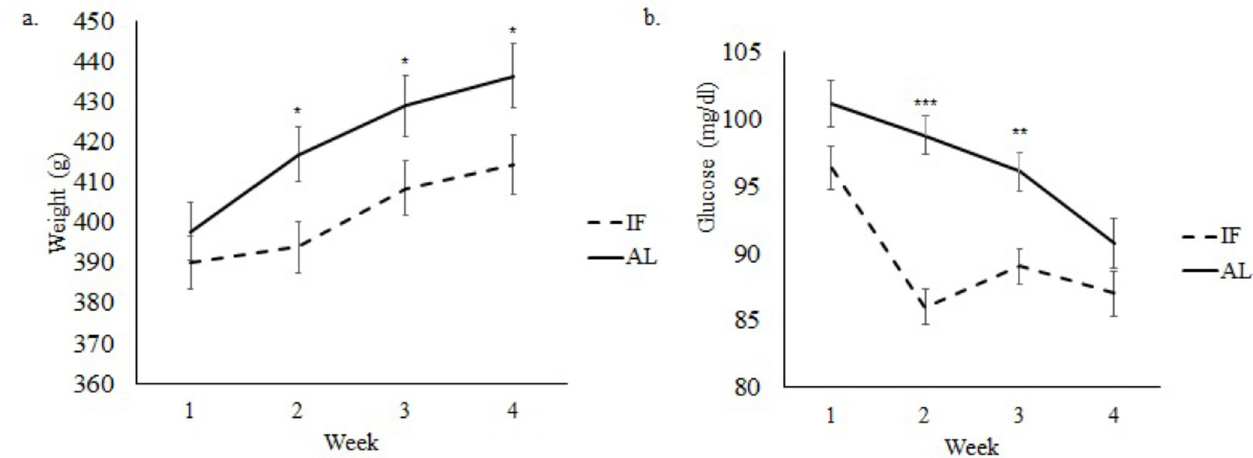
Fig 3. Body weight (a) and blood glucose levels (b) in the obese group.: � p < 0.05; �� p < 0.01; ��� p < 0.001. IF: intermittent fasting; AL: ad libitum ; HFD: high-fat diet; SD: standard diet. Error bars represent standard